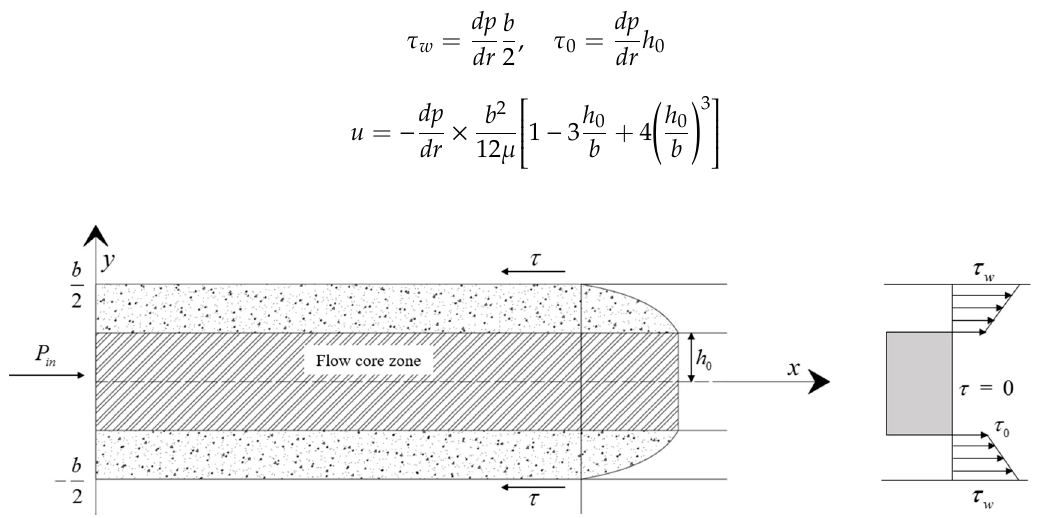
ff usion in a two-dimensional parallel